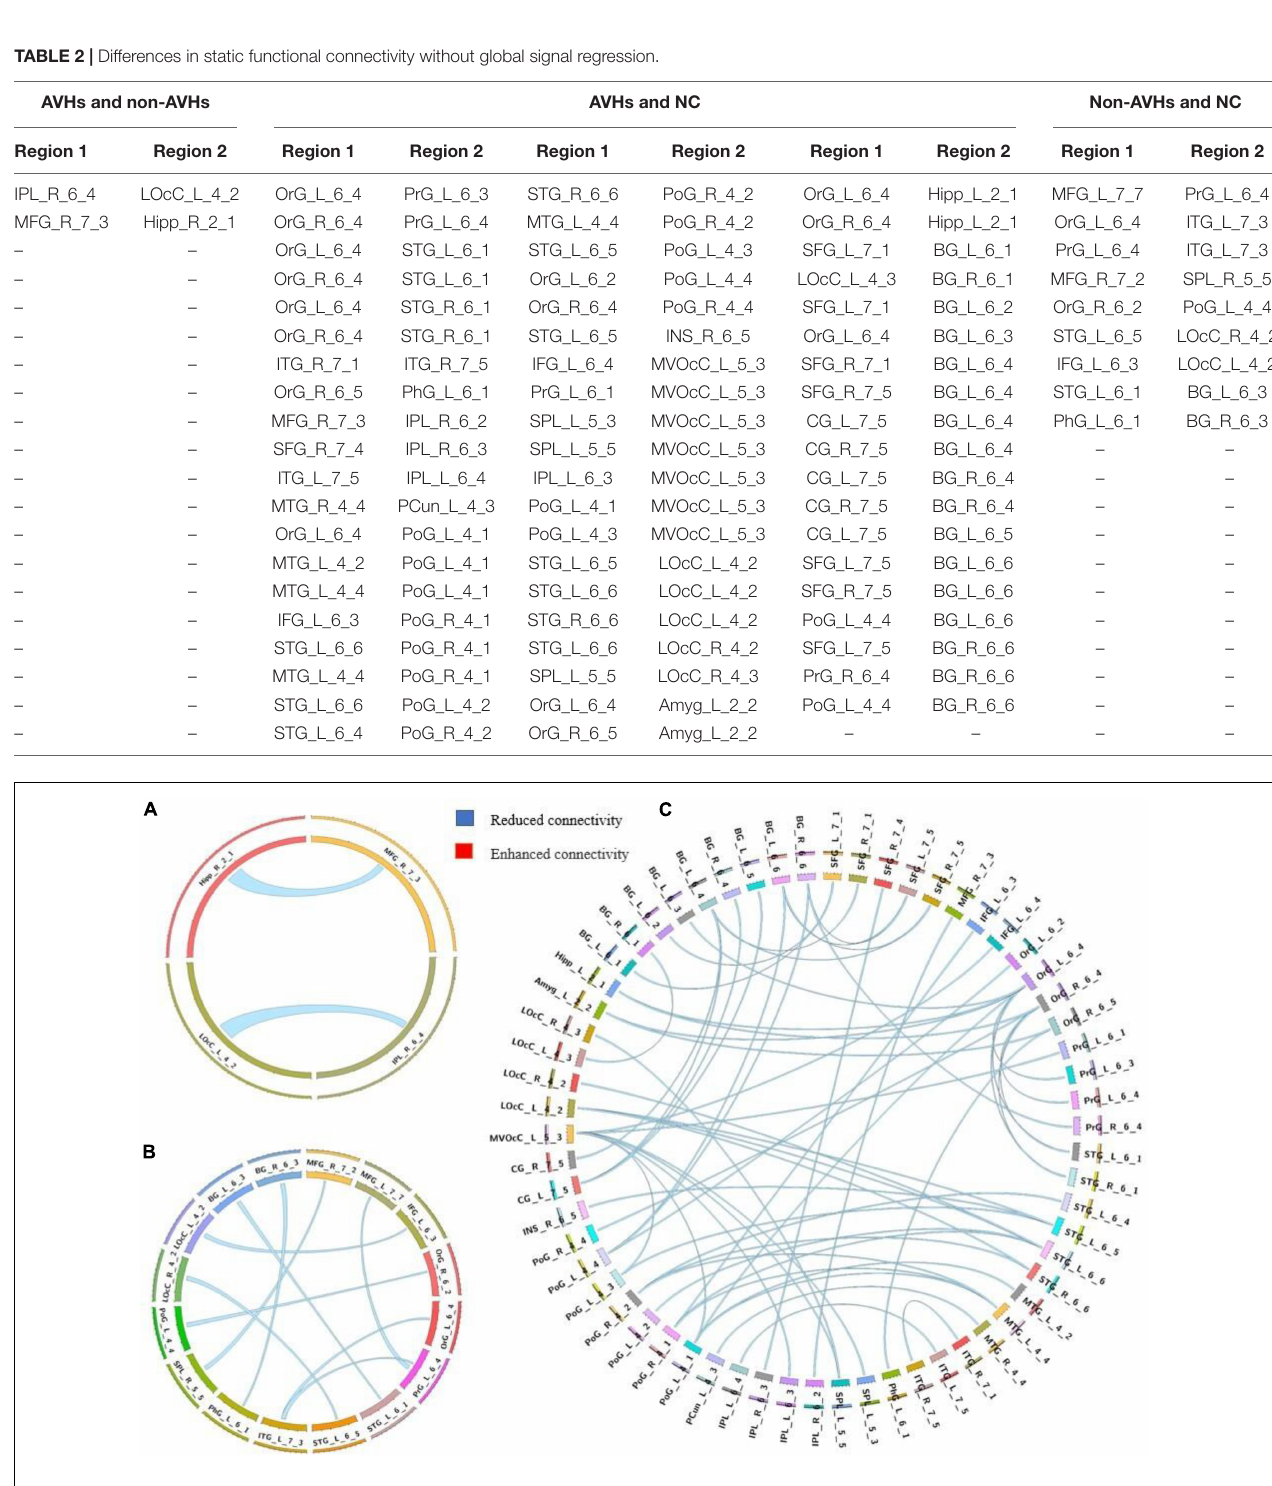
FIGURE 1 | Group differences in static functional connectivity without regressing out global signal. (A) AVHs group compared with non-AVHs group; (B) non-AVHs group compared with NC group; (C) AVHs group compared with NC group. Increased connectivity is shown in red and decreased connectivity is shown in blue.